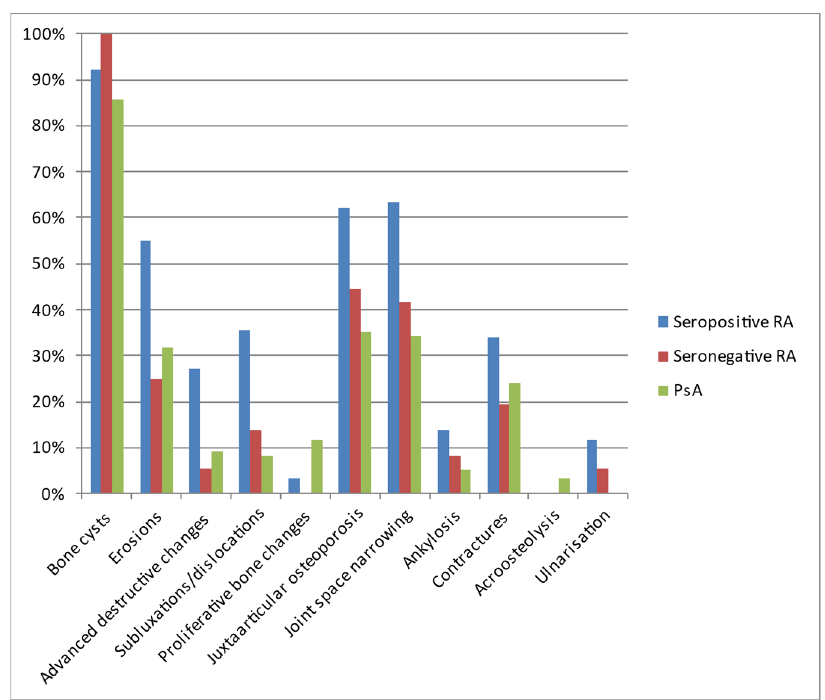
Figure 6. Types of lesions observed on hand radiographs of analyzed patients with seropositive RA, seronegative RA, and PsA.